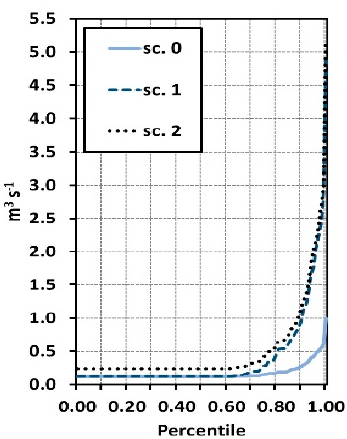
Figure 8. Outflow from the reservoir in scenarios of the restoration of the catchment area (percentile).